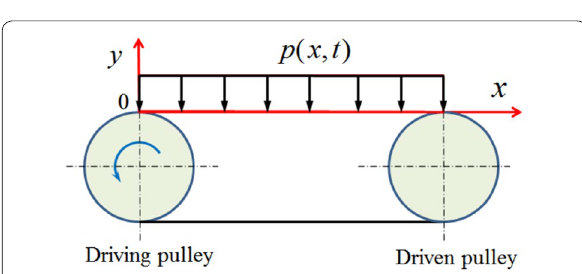
Figure 2 Coordinate system of a belt drive